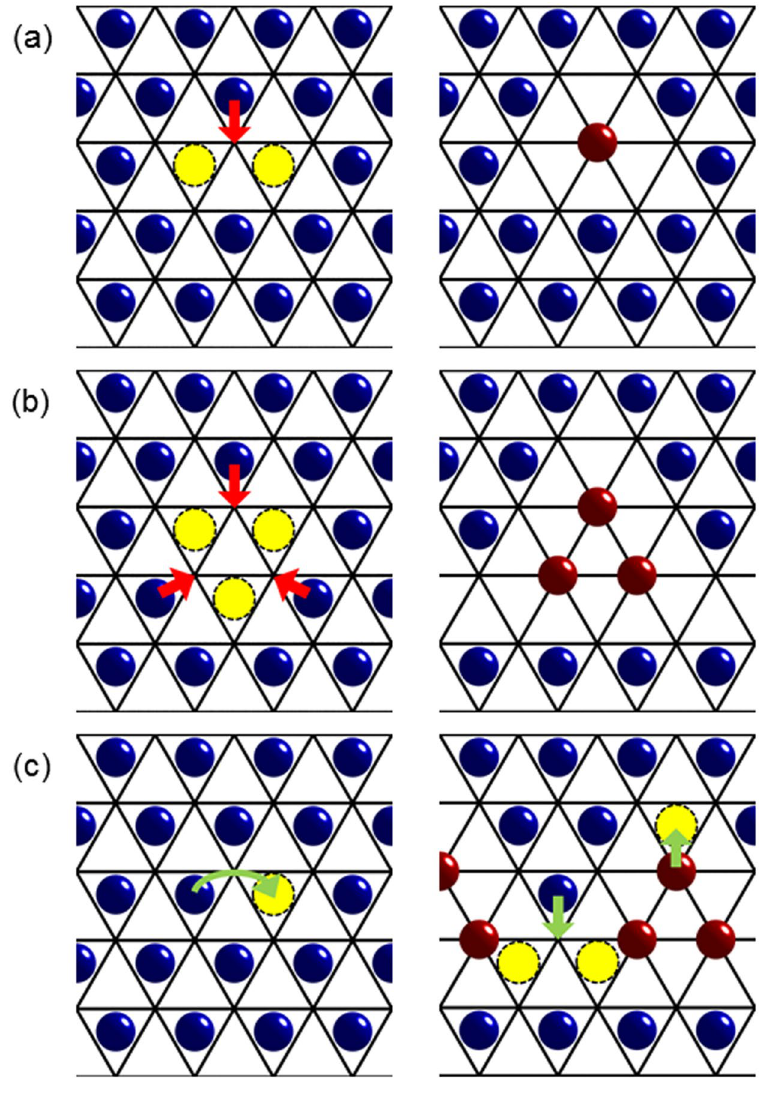
Figure 1. Multi-vacancy cluster formation and diffusion pathways in Na x CoO 2 . ( a ) For the di-vacancy cluster, left panel: there are two vacancies (yellow) on the underlying hexagonal lattice of 2 d sites (blue), and in the right panel: one Na ion is promoted (red arrow) from a 2 d site to a 2 b site (red). ( b ) For the tri-vacancy cluster, there are three “real” vacancies and three Na ions are promoted from 2 d to 2 b sites. ( c ) Diffusion pathways (green arrows). Left panel: for isolated vacancies the hopping is between 2 d sites, and in the right panel: in the presence of multi-vacancy clusters there is hopping between 2 b and 2 d